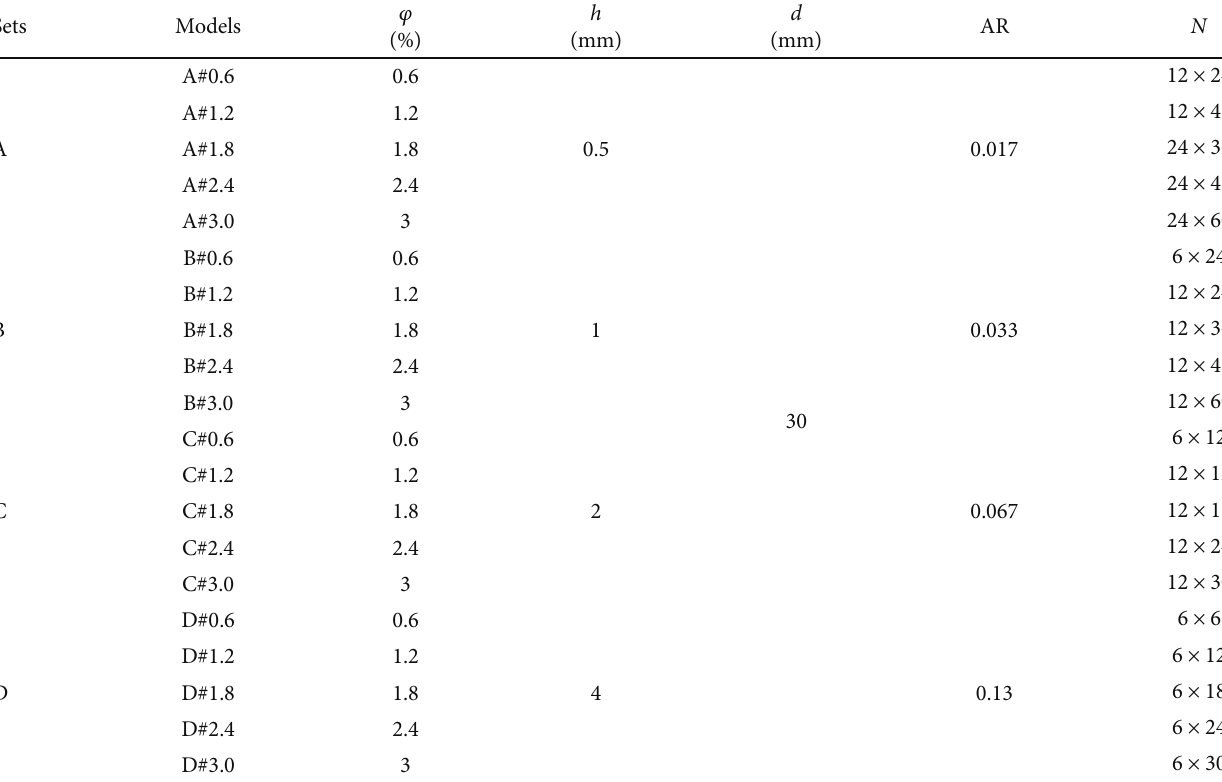
Table 3: Model sets and the corresponding